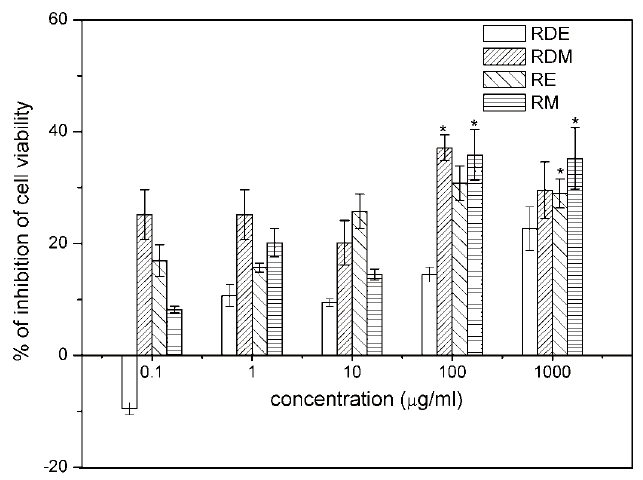
Fig. 2: The influence of different rue samples on HeLa cell viability (% of inhibition of cell viability) after 24 h of incubation. Differences of the effects of different Ruta graveolens extracts (RM – methanolic extract of wild growing plants, RDM – methanolic extract of cul- tured plants, RE – ethanolic extract of wild growing plants, RDE – ethanolic extract of cultured plants) in different concentrations to untreated control were checked using t-test, significant differences p<0.01 being marked with